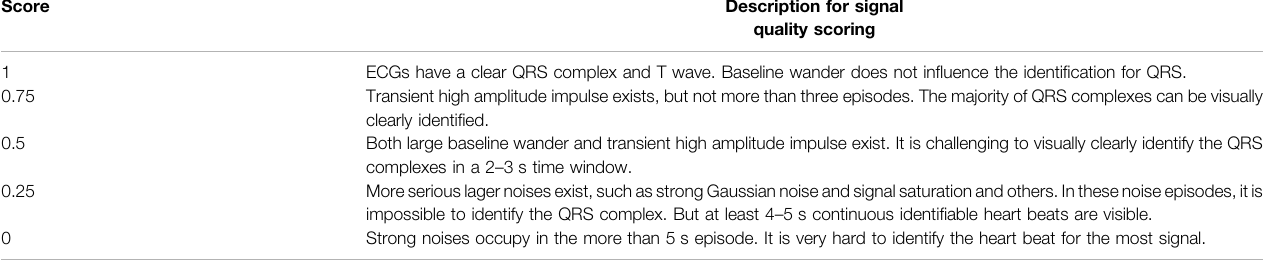
TABLE 1 | Five signal quality scores for the 10-s ECG segments. Score Description for signal